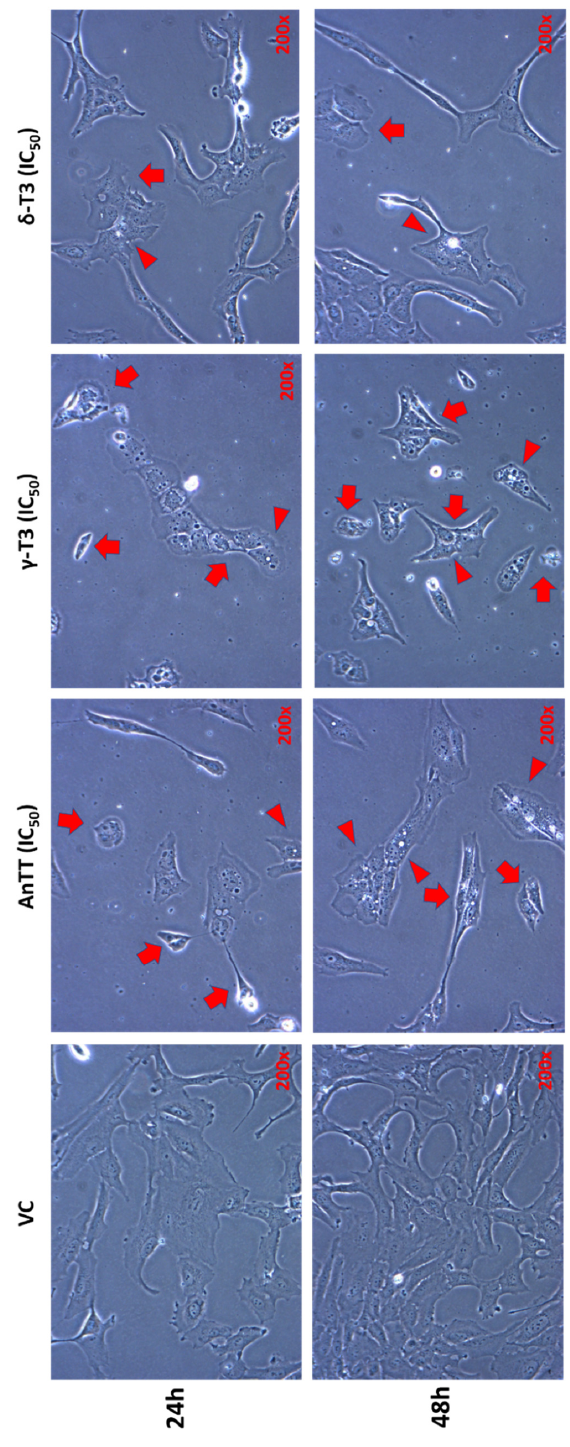
Figure 3. Morphological changes of SW1353 cells upon 24 h and 48 h AnTT, γ -T3 and δ -T3 treatment. SW1353 cells in the VC group exhibit typical spindle-shaped adherent cell morphology. Tocotrienol- treated SW1353 cells show abnormal morphological changes (arrow), such as cell shrinkage, elongated or squamous cell shape, and massive cytoplasmic vacuolation (arrowhead), especially upon 48 h treatment. Abbreviations: AnTT, annatto tocotrienol; δ -T3, δ -tocotrienol; γ -T3, γ -tocotrienol; IC 50 , half-maximal inhibitory concentration; VC, vehicle